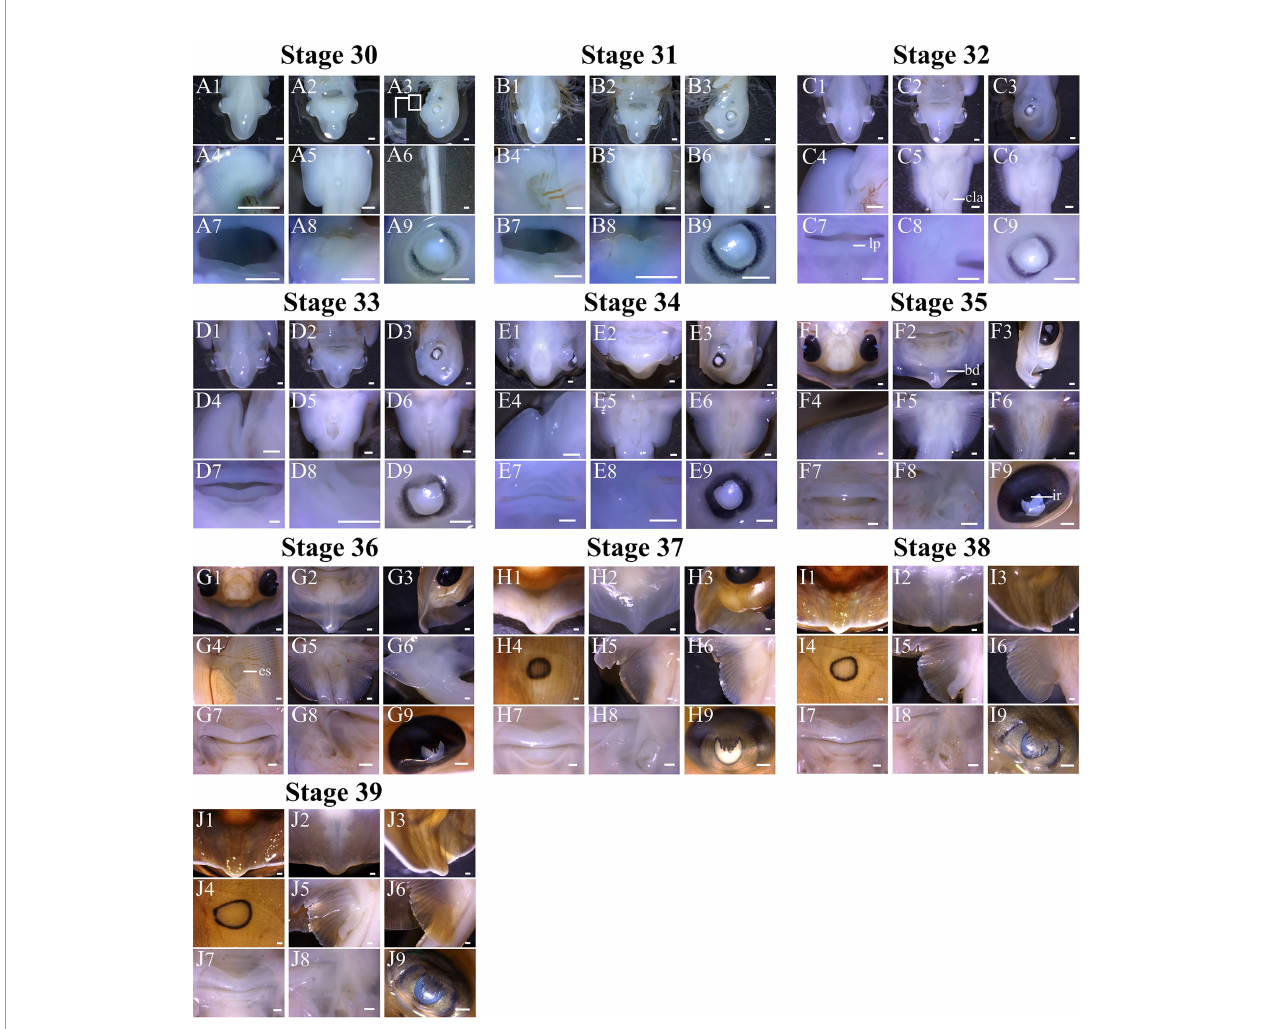
FIGURE 5 | Key characteristics of O. kenojei embryos in developmental stages 30 – 39. Bar = 0.05 cm. The pictures of each stage labeled with 1, 2, and 3 show the changes in the embryo ’ s head. The labels (A4, B4, C4, D4, E4, F4) indicate the pectoral fi n. (G4, H4, I4, J4) show the eyespot. (A5, B5, C5, D5, E5, F5, G5, H5, I5, J5) indicate the development of male pelvic fi n. (A6) shows the dorsal fi n. (B6, C6, D6, E6, F6, G6, H6, I6, J6) show the development of the female pelvic fi n. The pictures of each stage labeled with 7, 8, and 9 show the development of the embryo ’ s mouth, nose, and eyes, respectively. cla, clasper; lp, lip; bd, body disc; ir, irises; es,